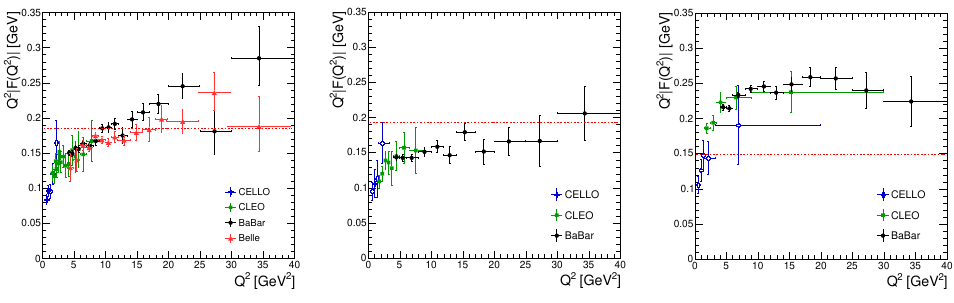
Figure 2: The TFF of π 0 (left), η (middle), and η (cid:48) (right) measured from the CELLO [ 21 ] , CLEO [ 22 ] , BaBar [ 18,19 ] , and Belle [ 20 ]